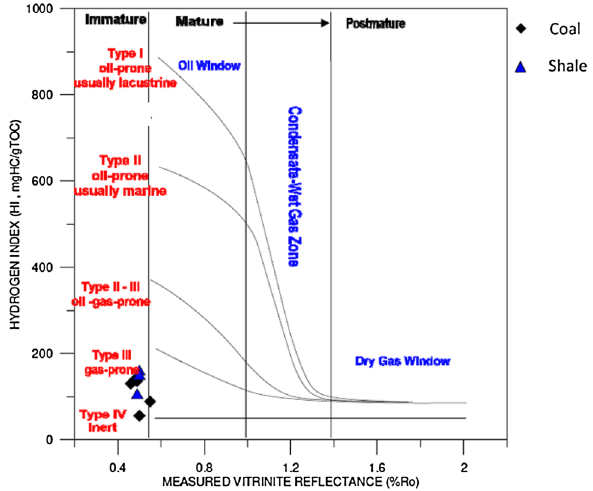
Fig. 10 Plot of hydrogen index (HI) against vitrinite reflectance of coal and shale samples from Maiganga mine, Gongola Basin. Most of the samples are immature and fall within type III kerogen (gas prone) typical of terrestrially sourced organic matter